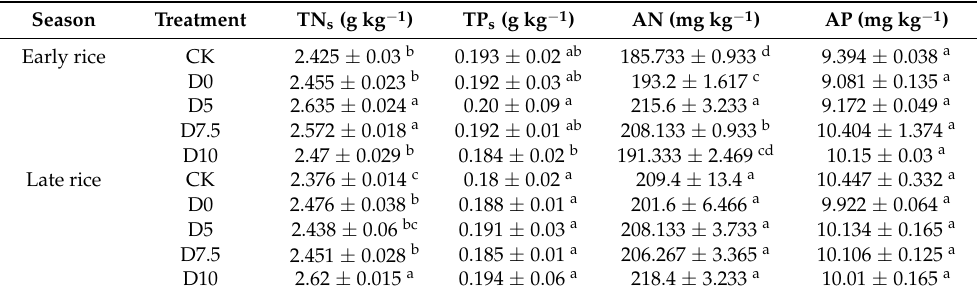
Table 2. Changes of nitrogen and phosphorus nutrients in soil under different fertilization-depth treatments at harvest